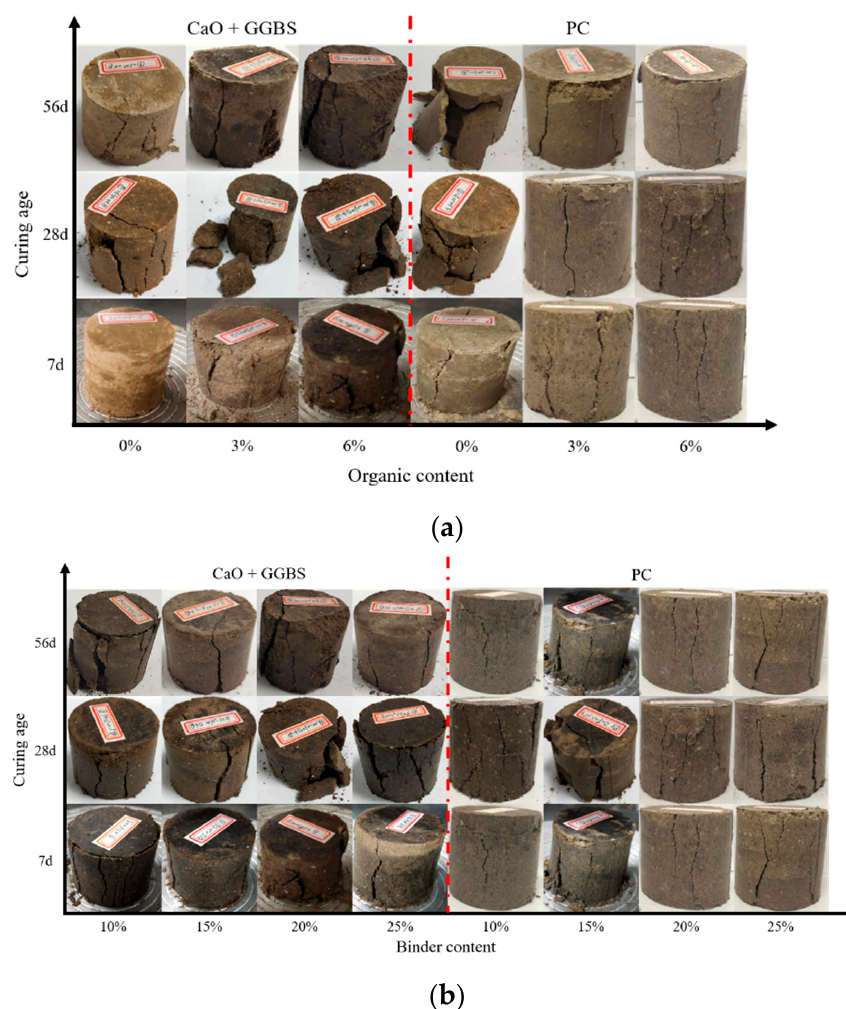
Figure 2. Surface forms of CG/PC-stabilized specimens after failure. ( a ) Influence of organic content. ( b ) Influence of binder dosage.